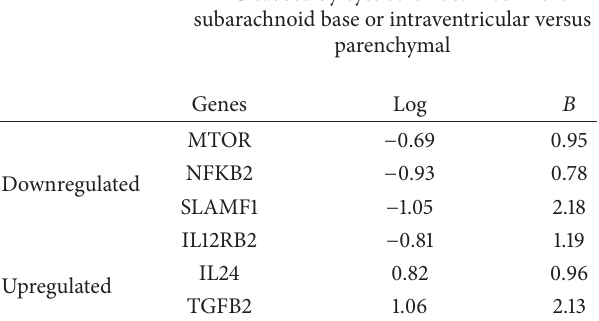
Table 3: Genes differentially expressed in NC patients with respect to the parasite location after 8 days of treatment. NC caused by cysticerci localized in the subarachnoid base or intraventricular